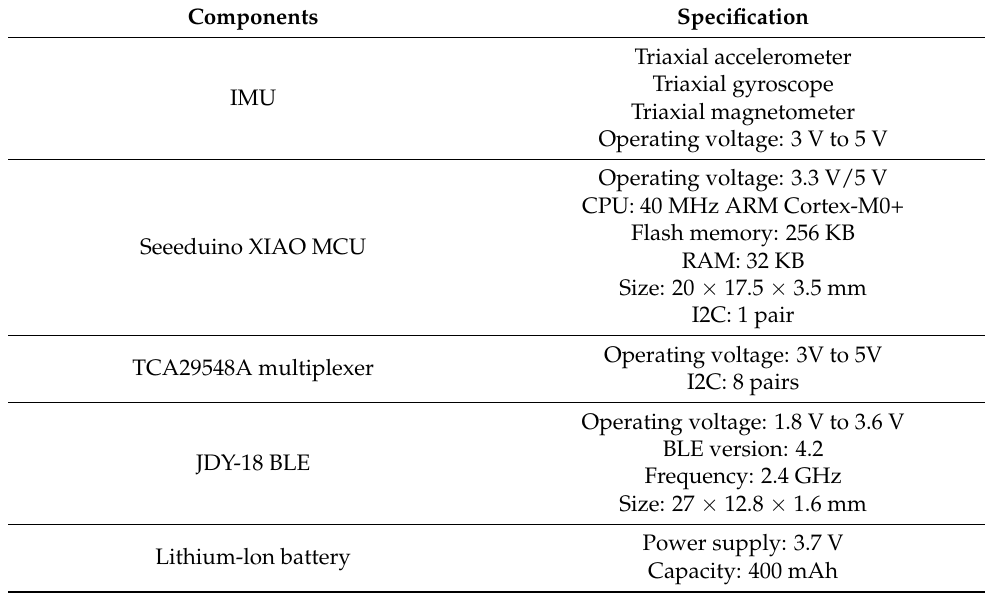
Table 1. Components and their respective specifications in the sensing